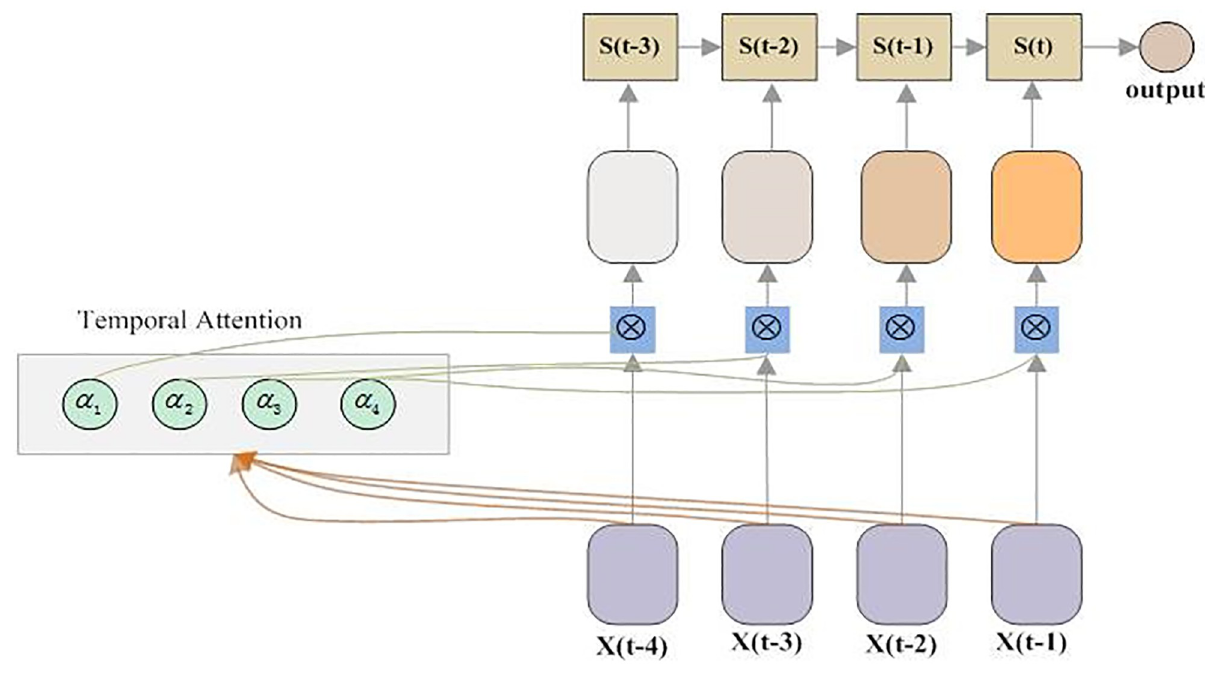
Fig 3. Principle of TA-LSTM